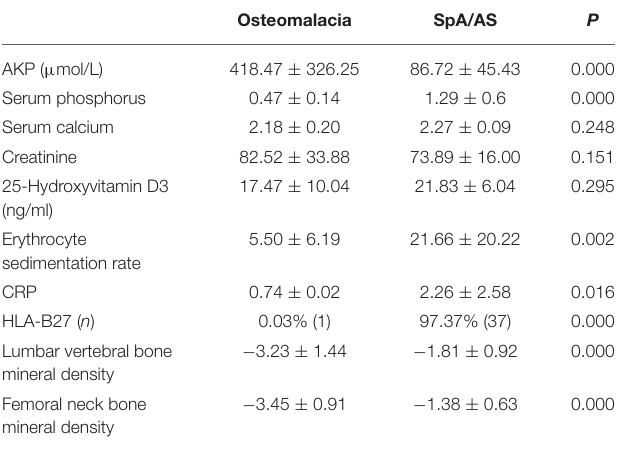
TABLE 3 | Laboratory test results of patients in both groups.